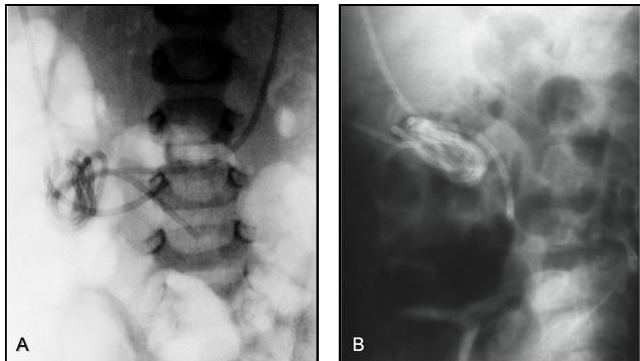
Figure 3 - A. Simple abdominal X-ray in AP, showing the entrapped peritoneal catheter, inside the intraperitoneal cavity. B. Simple abdominal X-ray in profile showing the folding of the peritoneal